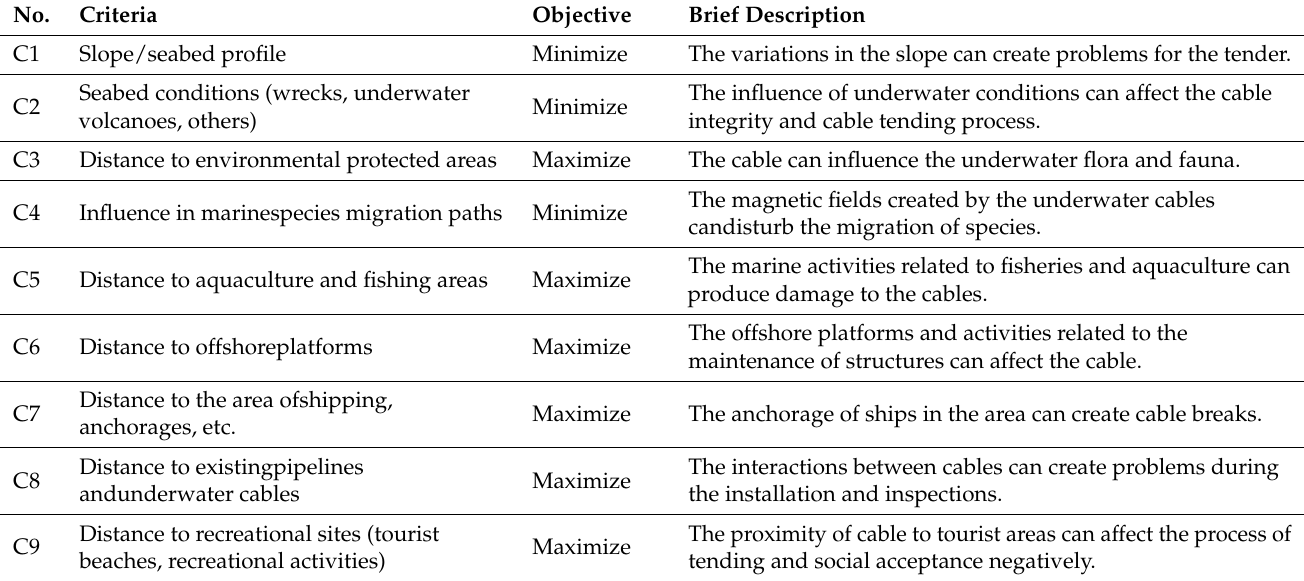
Table 2. Offshore wind export cable routing